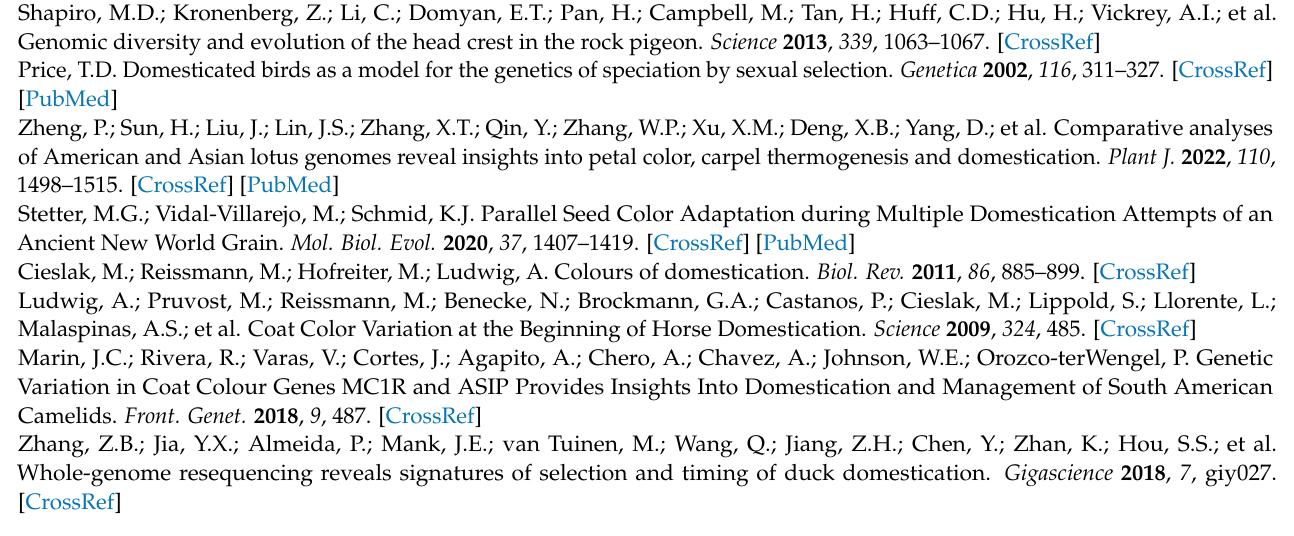
genes; Figure S5: Genome-wide selective signals across white plumage duck based on global FST (top) and log2 π ratio (bottom); Figure S6: Genome-wide selective signals across spot plumage duck based on global FST (top) and log2 π ratio (bottom); Figure S7: Genome-wide selective signals across gray plumage duck based on global FST (top) and log2 π ratio (bottom); Figure S8: